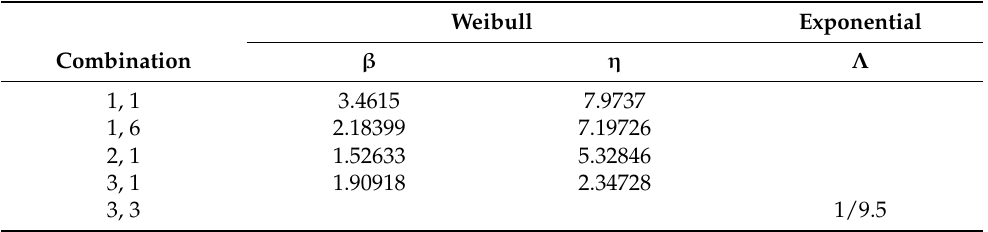
Table 8. Component–subsystem relationships presented in the failure analysis and their parameters